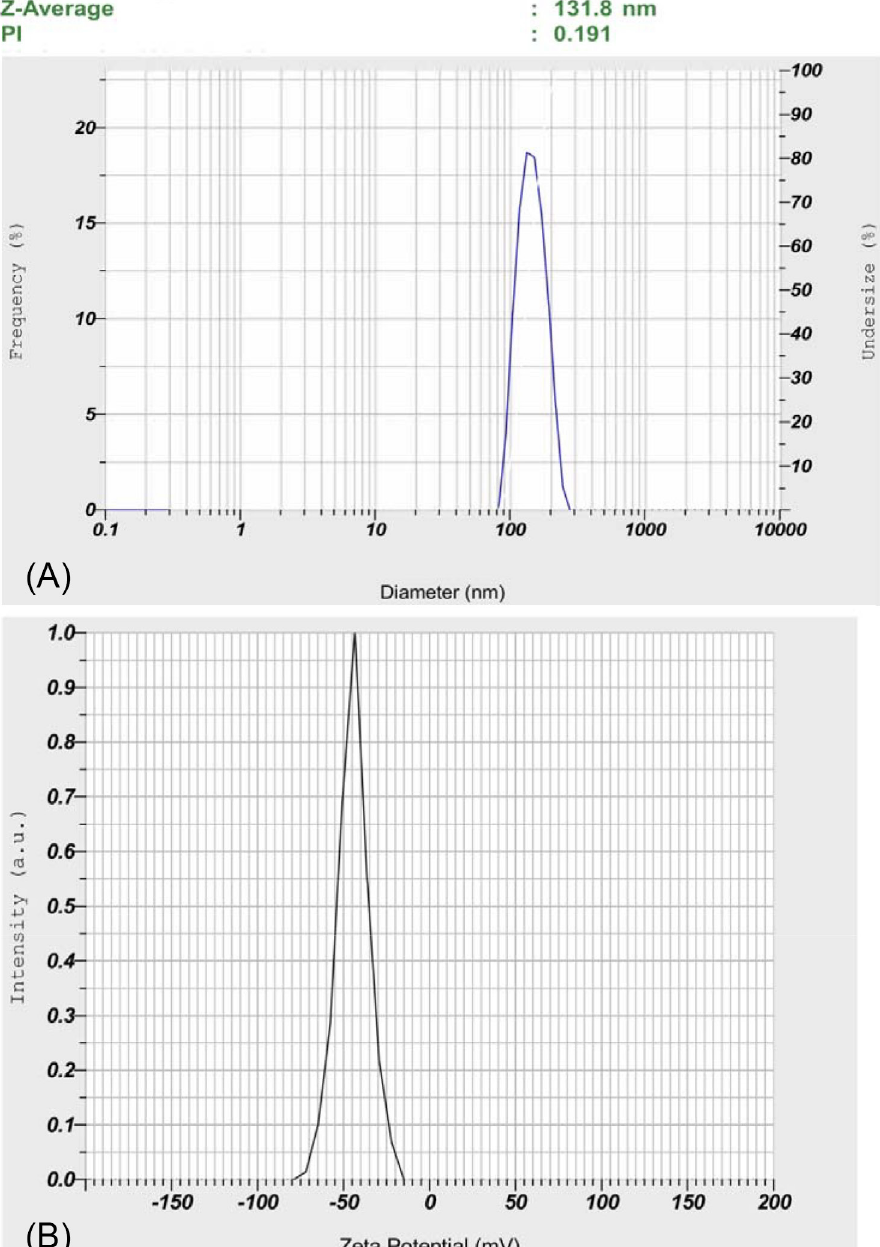
FIGURE 4 - Distribution of PEG-CUR size (A) and zeta potential